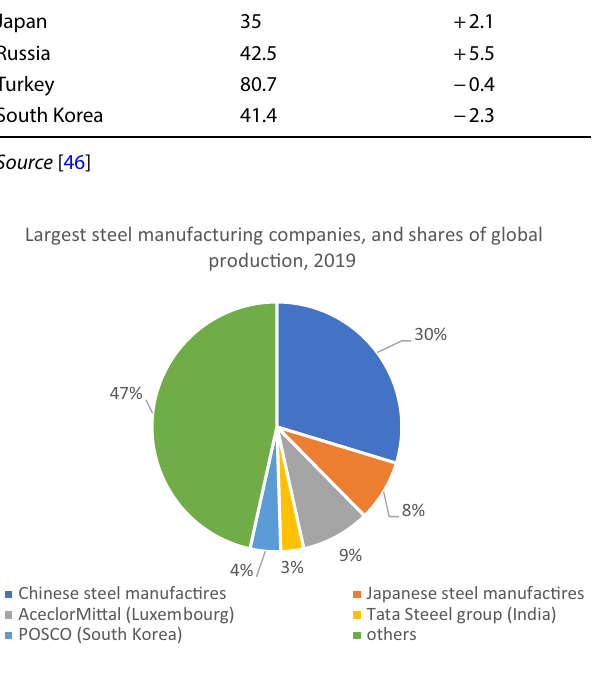
Table 10 Steel production—main processes